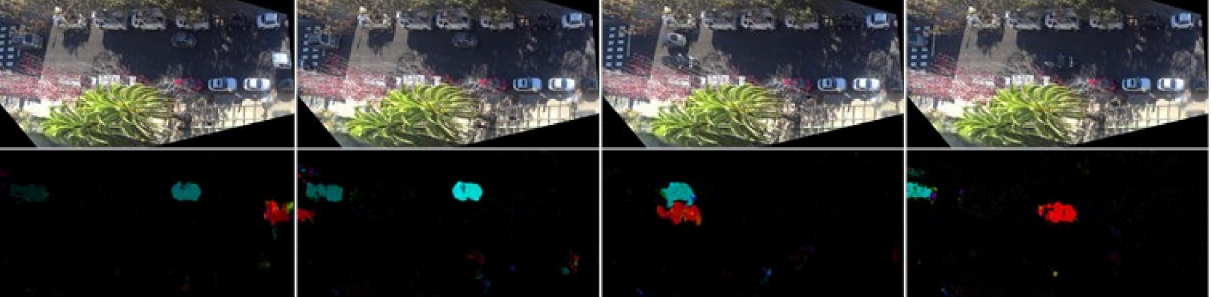
Figure 10. The result of optical flow method preprocessing picture. The upper picture is the road scene at different time points, and the lower picture corresponds to the optical flow field calculated by the upper picture and its previous